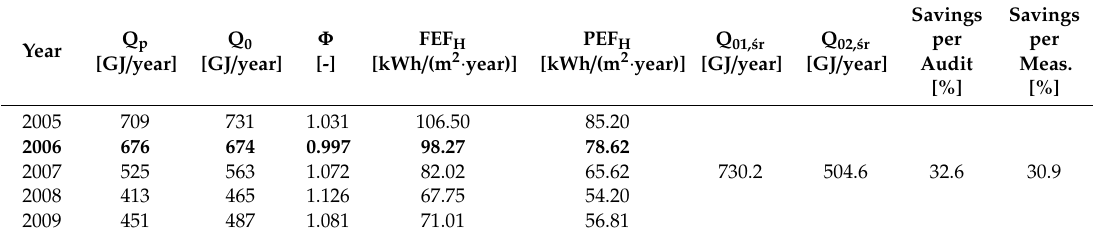
Table 3. Characteristics and heat consumption of an object from the group G1.